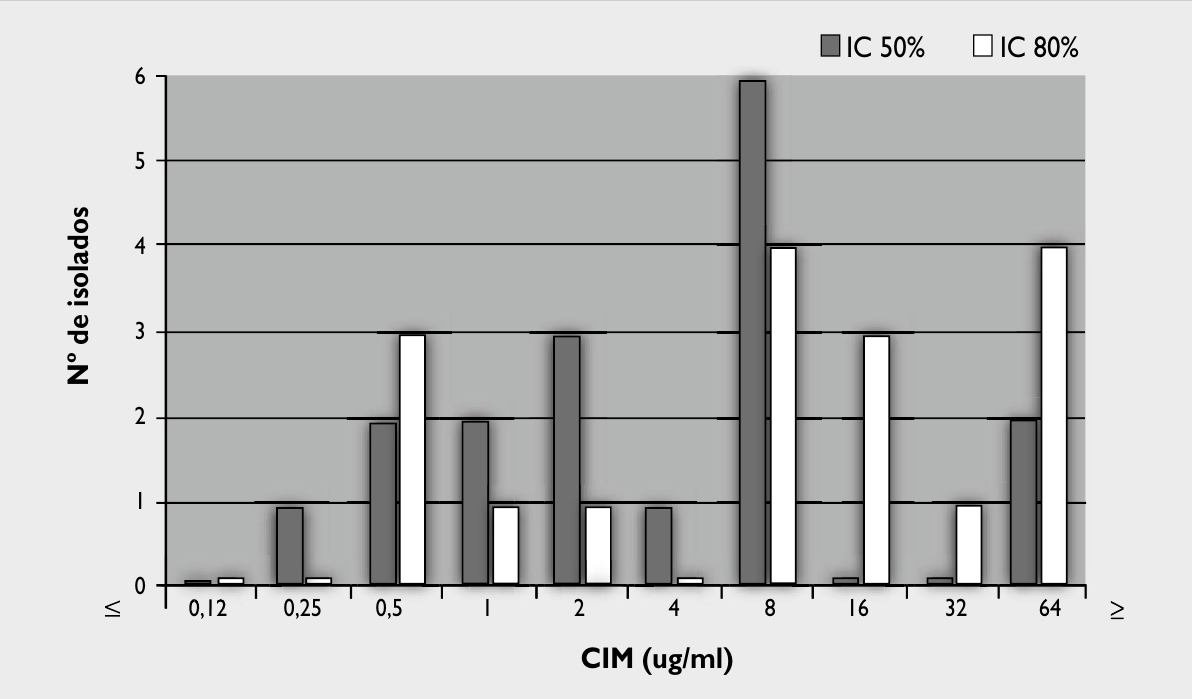
Figura 4 – Distribuição dos valores de CIM de fl uconazol, calculados para índice de inibição de 50% e 80%, em isolados de espécie não- albicans do fl uido vaginal de 17 pacientes